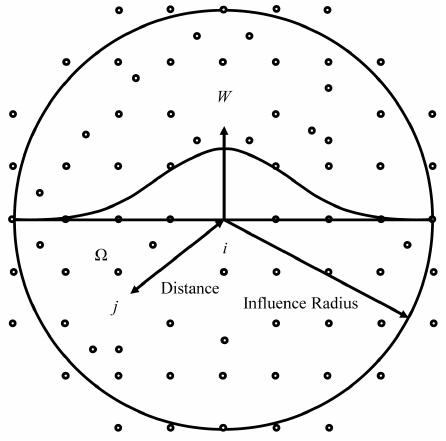
Fig. 3: Influence radius of a particle in a two-dimensional